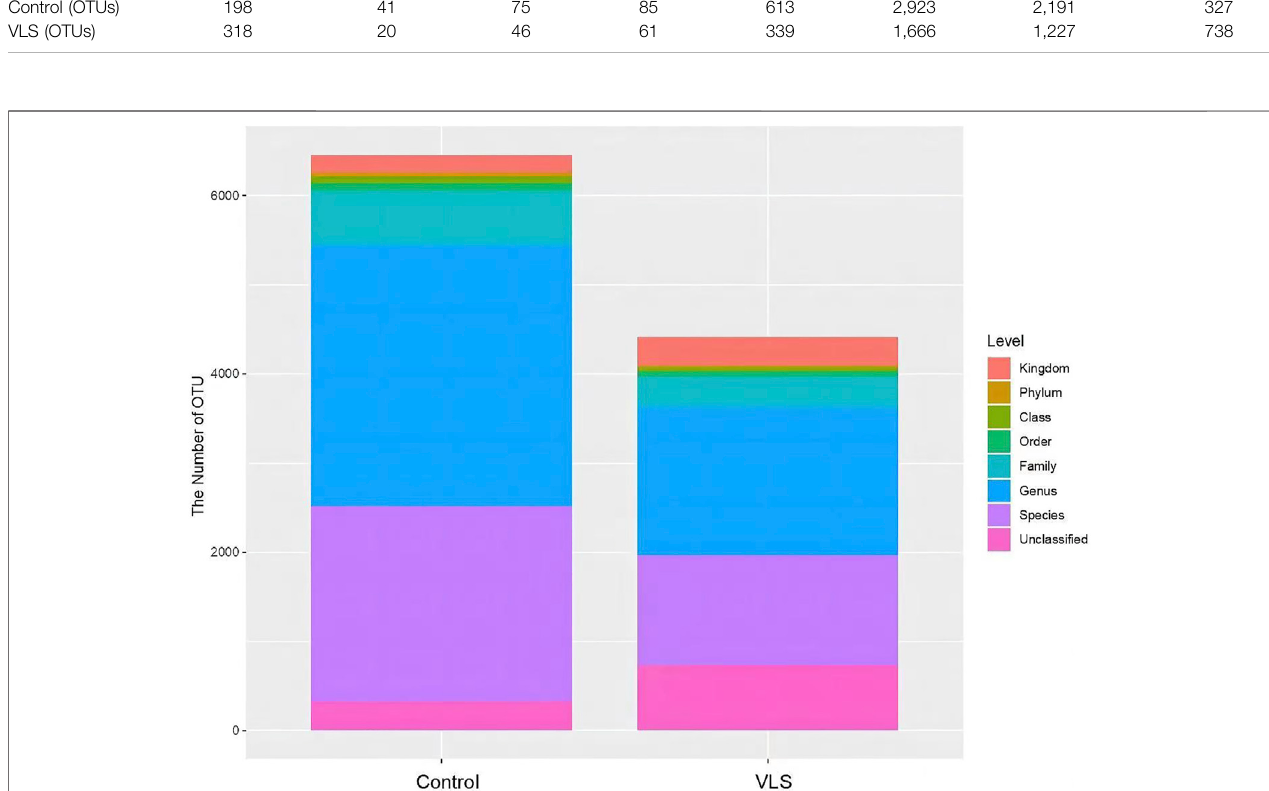
Frontiers in Cell and Developmental Biology |